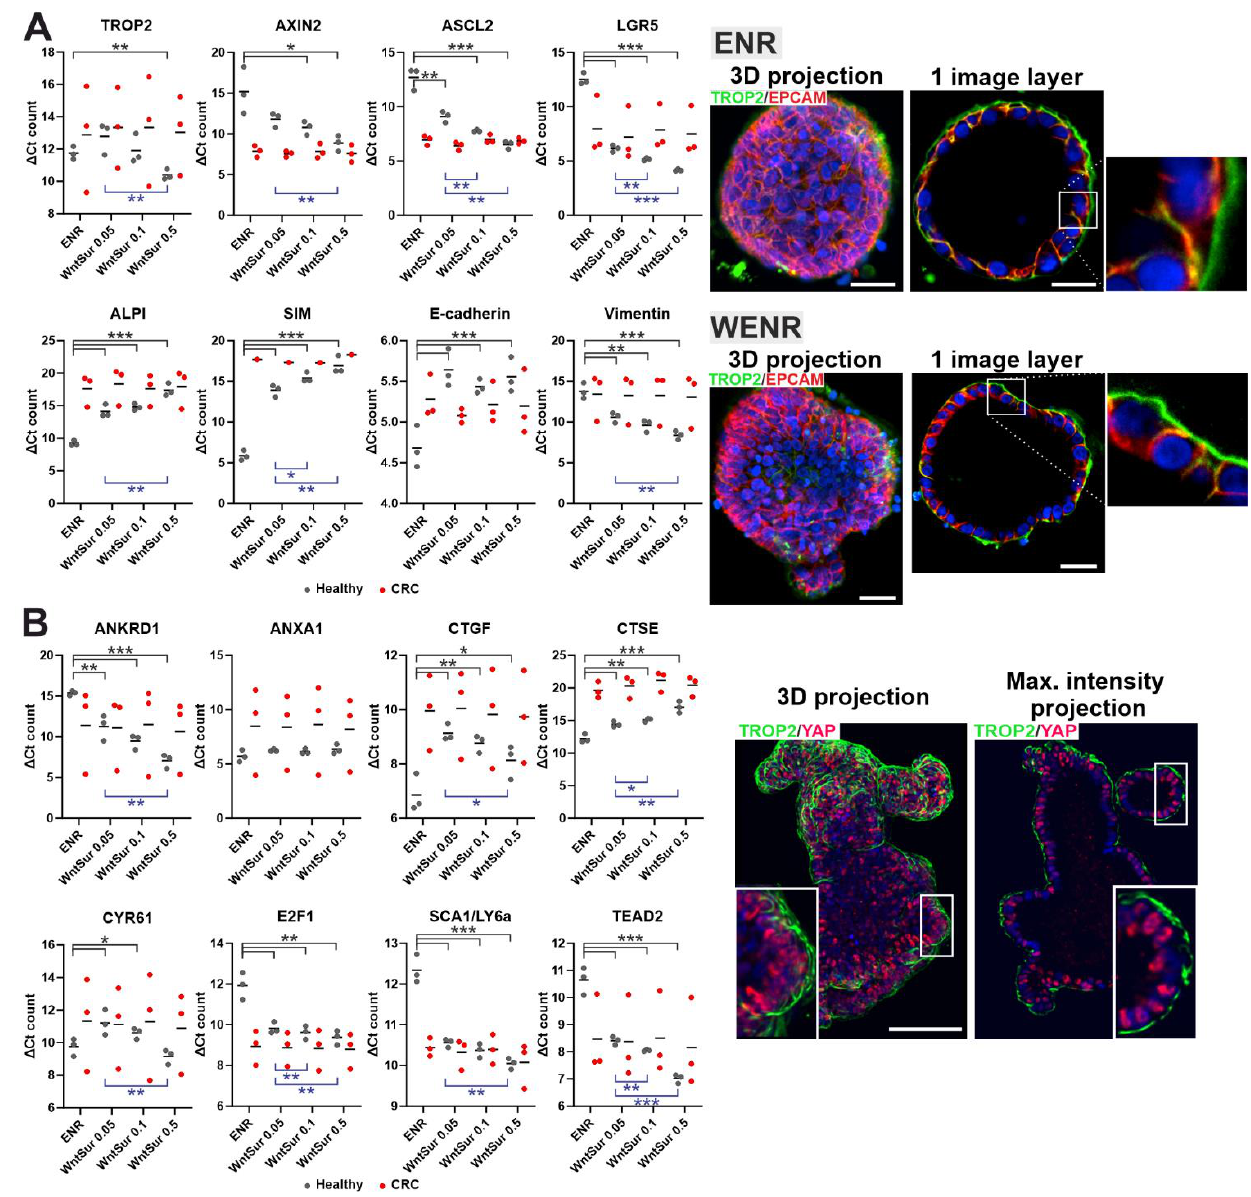
Figure 6. Hyperactivation of the Wnt pathway stimulates TROP2 in healthy colon organoids. ( A ) Left, qRT-PCR analysis of expression levels of the indicated genes in human healthy colon organoids (Healthy) and organoids derived from human CRC. The organoids were cultured either in standard organoid medium (ENR), or in ENR medium supplemented with next-generation surrogate Wnt ligand (WntSur) at final concentrations of 0.05 nM, 0.1 nM, and 0.5 nM (WntSur 0.05, WntSur 0.1, and WntSur 0.5, respectively). RNA samples isolated from three healthy and three tumor organoid cultures were analyzed (each in technical triplicate; the average value of each triplicate is repre- sented by a grey or red dot, respectively). The diagram shows ΔCt counts, i.e., the cycle threshold (Ct) value of the gene of interest minus the Ct- value of housekeeping gene β -ACTIN (the lower the ΔCt value, the higher the gene expression); black lines indicate the mean value for three biological replicates; * p < 0.05; ** p < 0.01; *** p < 0.001. Wnt/β -catenin target genes — axis inhibition protein 2 (AXIN2), achaete-scute complex homolog 2 ( ASCL2 ), leucine-rich repeat containing G protein-cou- pled receptor 5 ( LGR5 ); differentiation markers — alkaline phosphatase ( ALPI ), sucrase-isomaltase ( SIM ); and genes related to the EMT status — E-cadherin and vimentin. Right: fluorescent micros- copy images of TROP2 (membranous green fluorescent signal) in tumor organoids derived from human CRC; organoids with intermediate levels of TROP2 mRNA (ΔCt value ± 13, see the very left diagram) were used for the staining. The organoids were cultured either in the ENR medium alone or in the ENR medium containing 0.5 nM WntSur (WENR). Note that the TROP2 protein expression